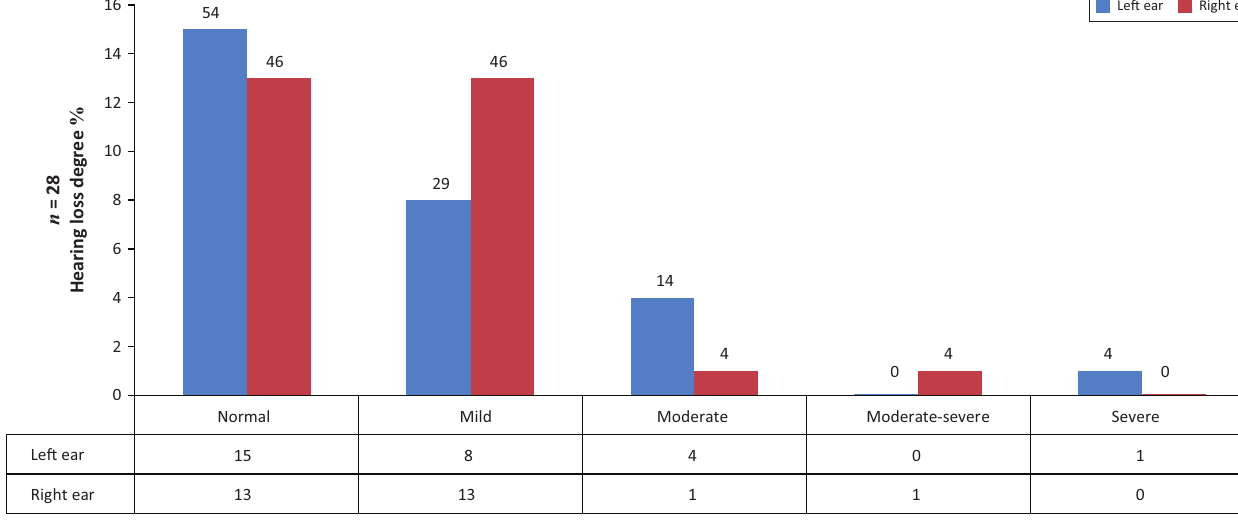
FIGURE 1: Hearing loss degree.